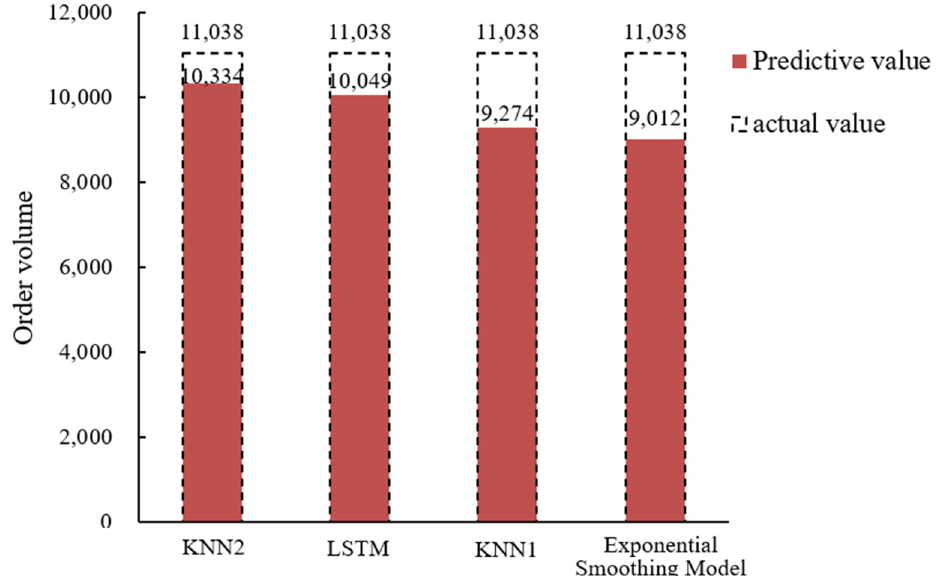
Figure 7 . C omparison of the predicted values of online car-hailing demand by different models. Figure 7. Comparison of the predicted values of online car-hailing demand by different